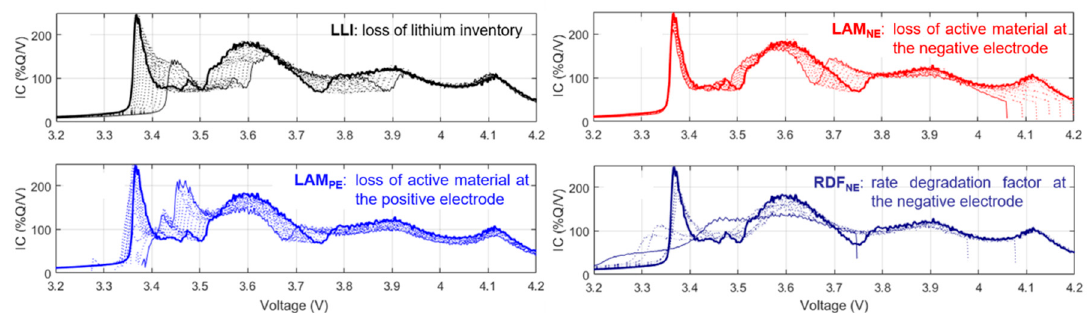
Figure 5. Simulated evolution of the IC curves for each of the prominent degradation modes generated by the ‘alawa program. More details are available in a previous work [14].